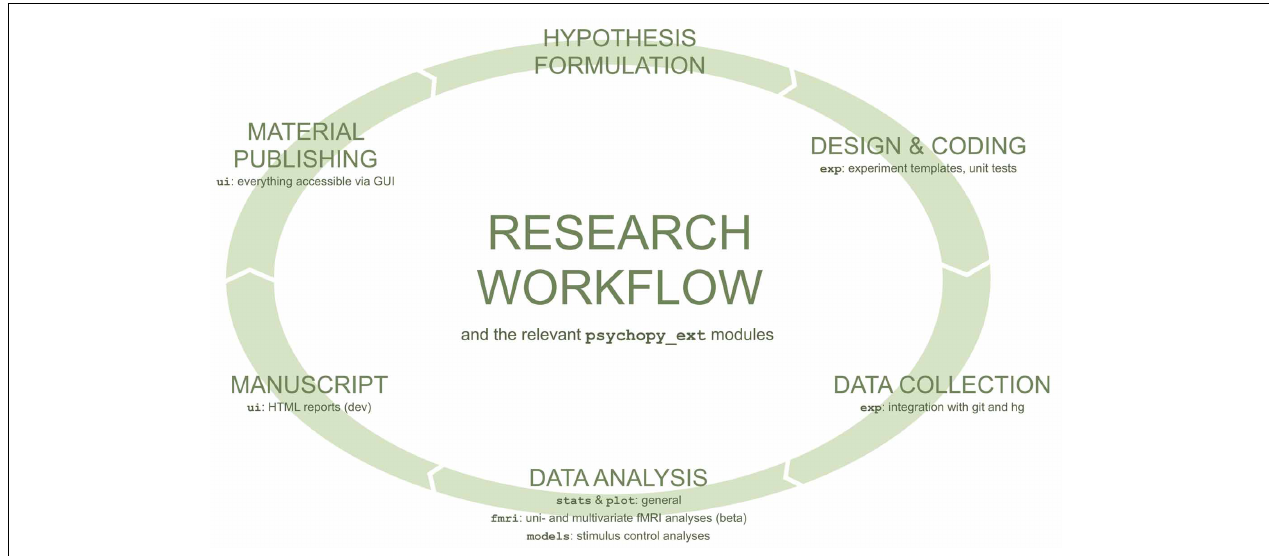
FIGURE 1 | A typical research workflow in neuroscience and psychology. For each task, modules from psychopy_ext that streamline the particular task are listed. Figure adapted from Kubilius